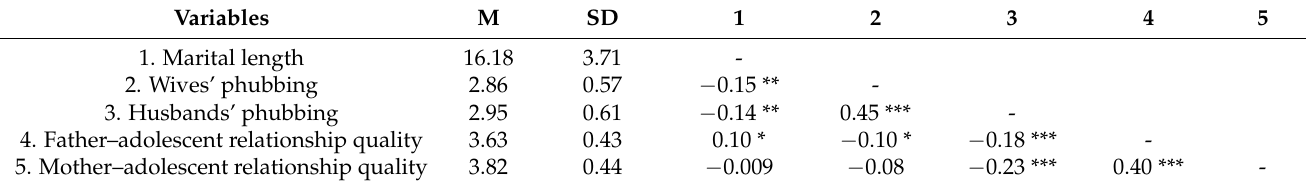
Table 1. Means, standard deviations, and correlation coefficients among the study